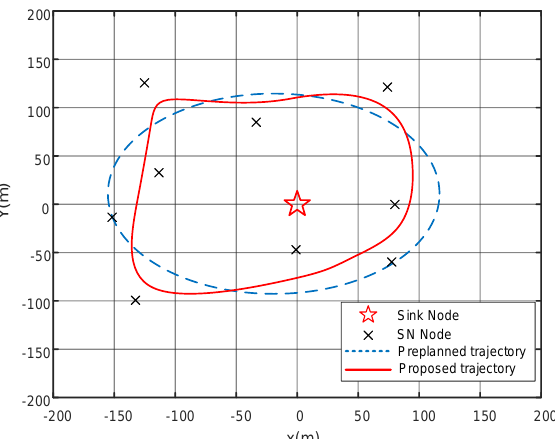
Figure 2. The proposed recursive random search (RRS)-based unmanned aerial vehicle (UAV) trajectory algorithm and preplanned